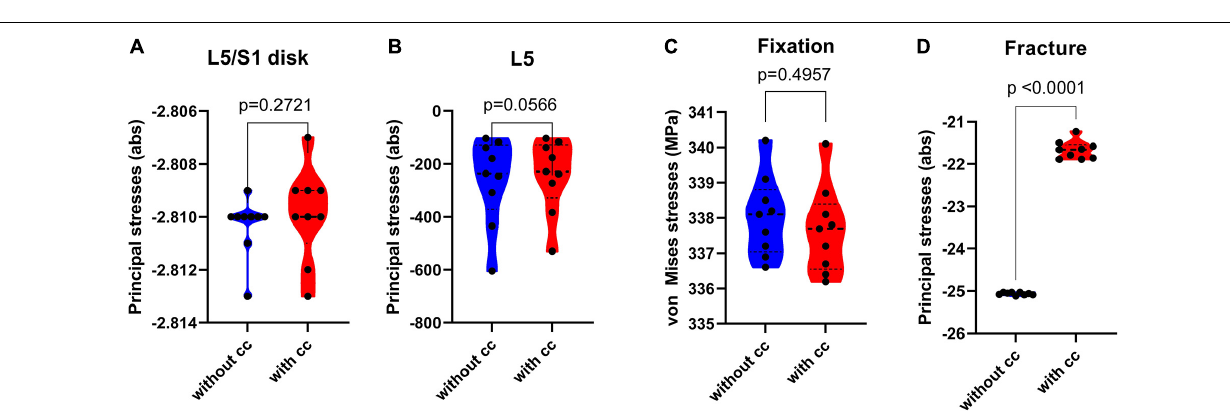
FIGURE 8 | Violin plots depicting the maximum principal stresses (absolute values) in the disk L5/S1 (A) , fifth lumbar vertebrae (B) and fracture area (D) and the von Mises stresses in the fixation device (C) in MPa, statistically validated in different variations of osseointegration (100 MPa to 10.000 MPa) for the axial rotation case. In the disk area L5/S1, the resulting effect of a cross connector was not significant [ F (1,8) = 1.391, p = 0.2721, SS = 8.89*10ˆ-7, δ = 0.0004, subplot A]. In the lumbar vertebra L5 [ F (1,8) = 4.955, p = 0.0566, SS = 1842, δ = 20.23, subplot B] and fixational device [ F (1,8) = 100, p < 0.0001, SS = 0.68, post-hoc t-test t (16) = 0.6971, p = 0.4957, δ = 0.39, subplot C], the effect of a cross connector was not significant. In the fracture area, the resulting principal stresses (subplot D) were significantly lower after the addition of a cross connector [ F (1,8) = 2066, p < 0.0001, SS = 51.78, post-hoc t-test t (16) = 46.28, p < 0.0001, δ = 3.392] (Mean, 25th and 75th